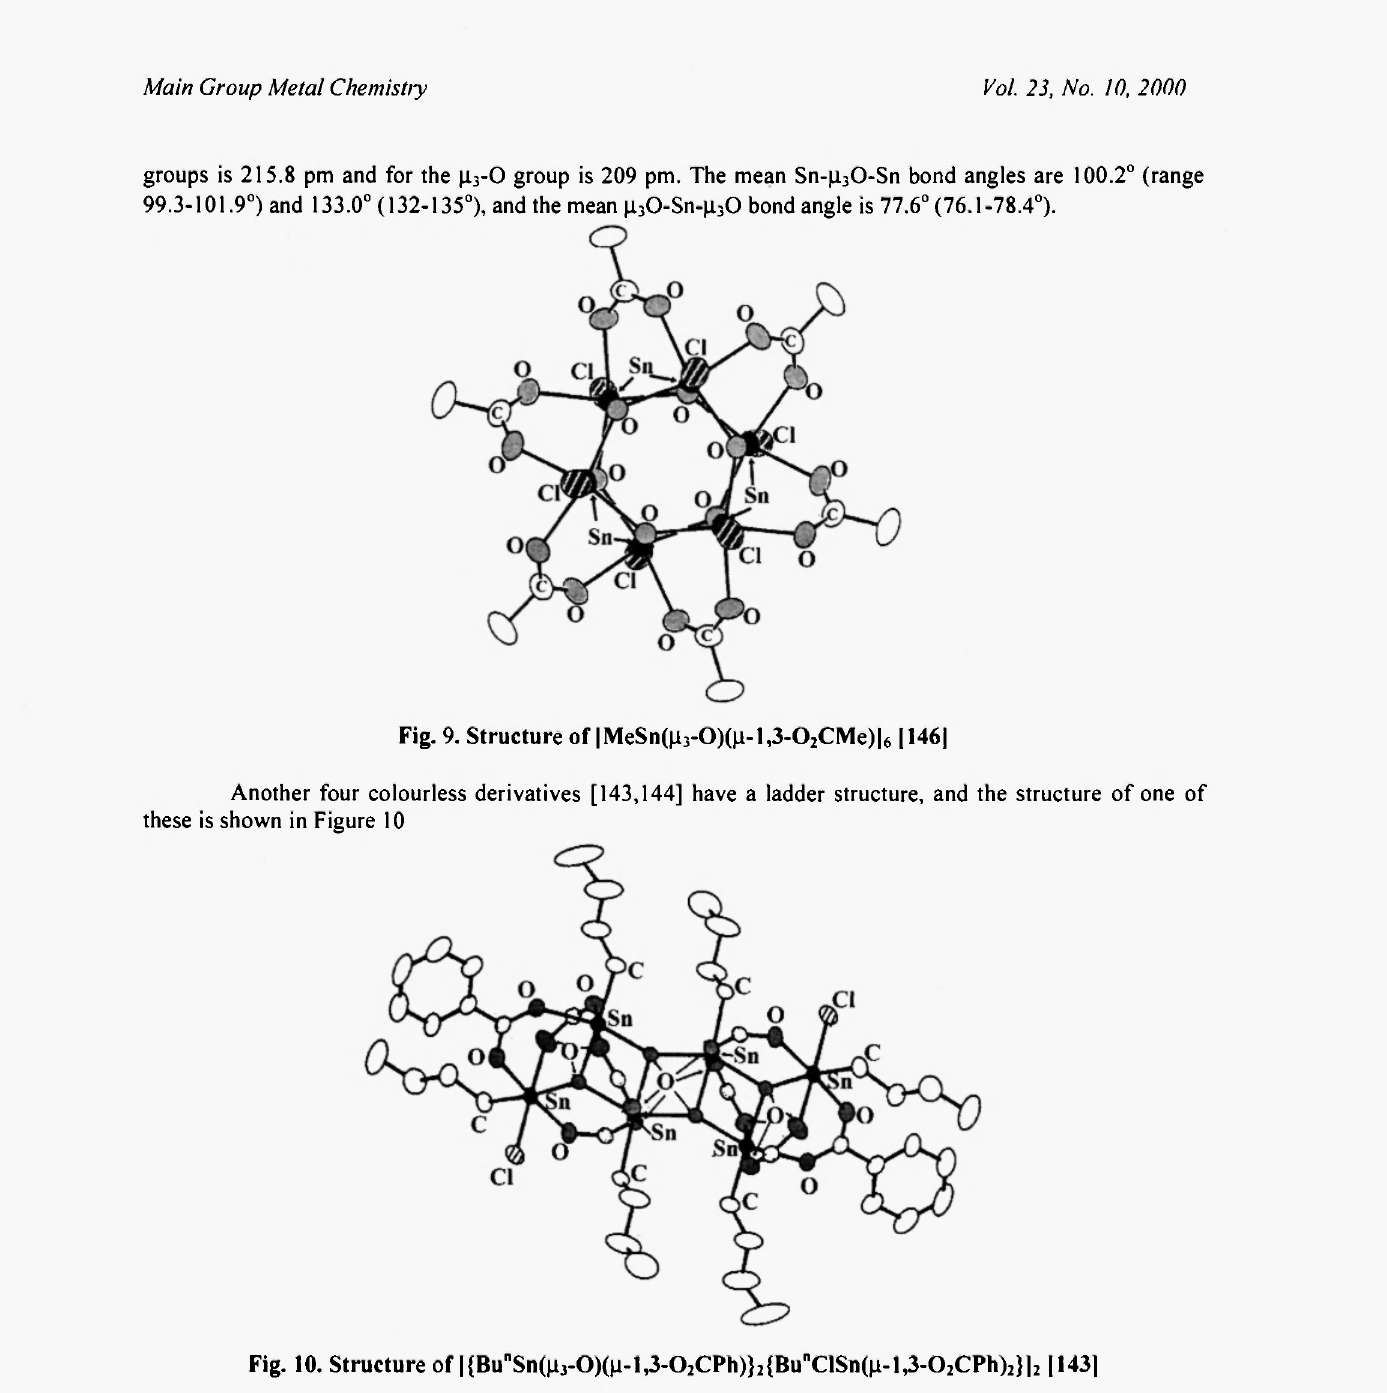
Fig. 10. Structure of |{Bu"Sn^ 3 -0^-13-0 2 CPh)} 2 {BuTlSn^-l,3-0 2 CPh) 2 }| 2